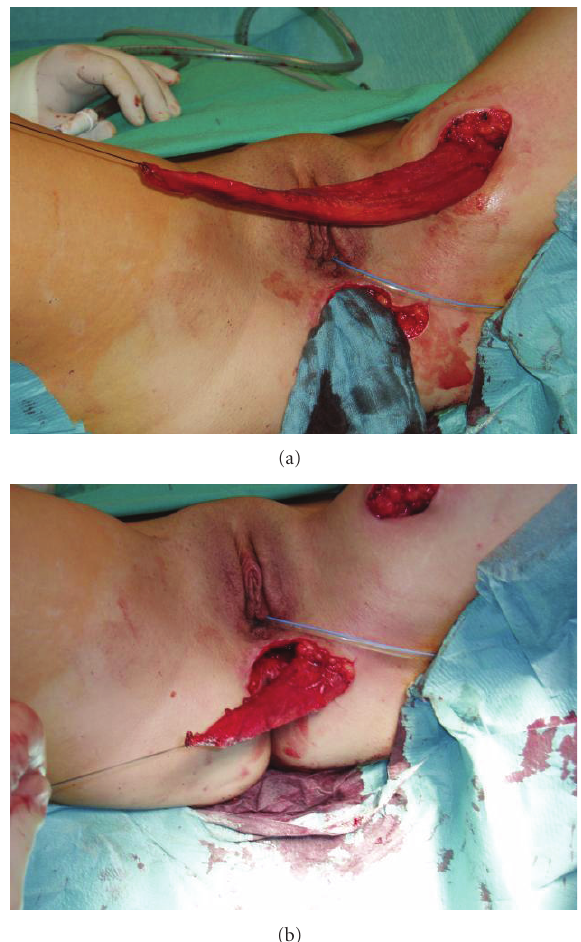
Figure 2: The gracilis muscle flap was identified then elevated trough a subcutaneous